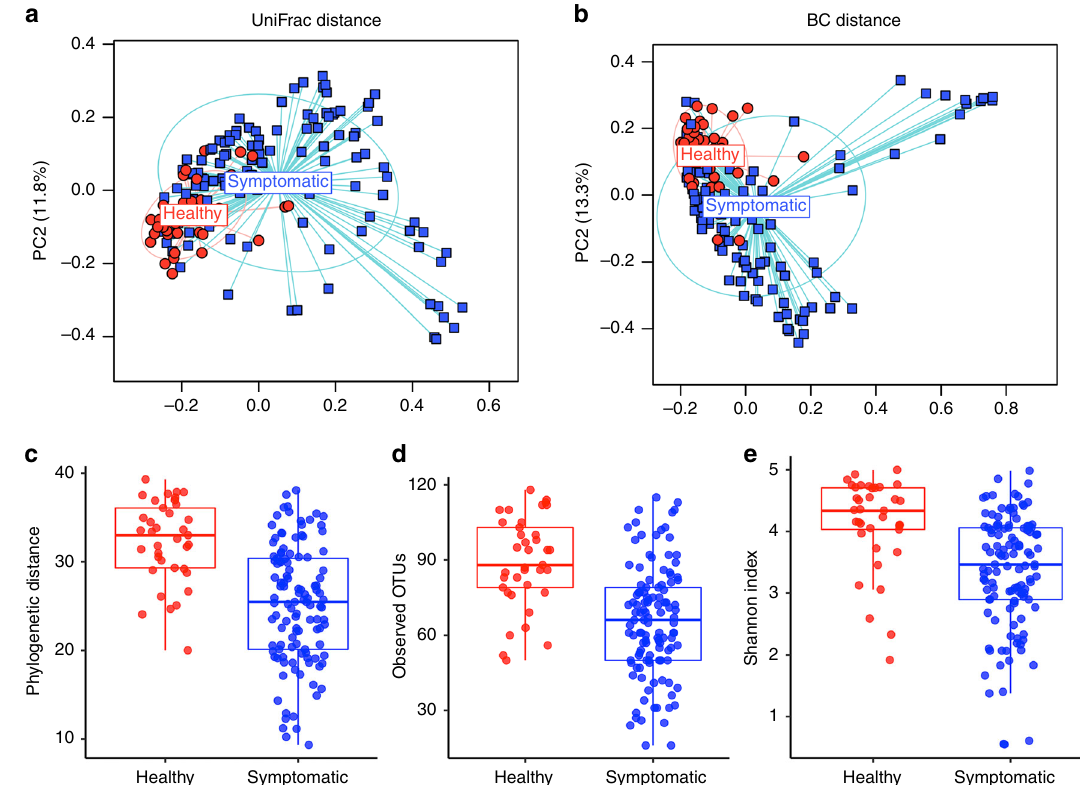
Fig. 1 The duodenal microbiome is altered in patients with GI symptoms. Principal coordinate axis (PCoA) plot showing beta diversity of patients with GI symptoms ( n = 126, blue) and healthy controls ( n = 38, red) based on a unweighted UniFrac and b Bray – Curtis distances ( p = 0.001, PERMANOVA). Alpha diversity (within subject) of patients with GI symptoms ( n = 126, blue) and healthy controls ( n = 38, red) based on c phylogenetic distance d observed OTUs and e Shannon diversity index metrics (rare fi ed to 5000 sequences; p < 0.0001, t test). Tukey boxplots show the median with IQR